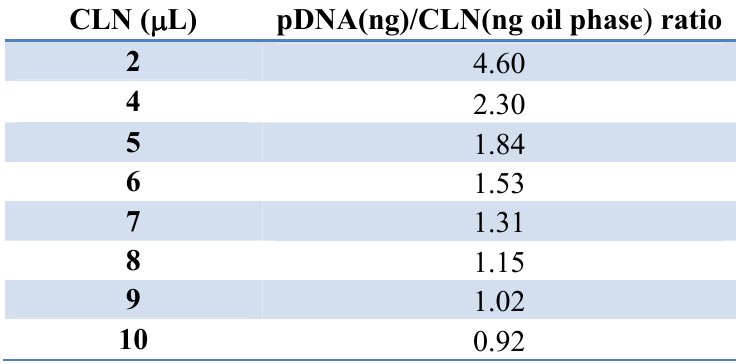
Table 2. Study concentration of CLN and its corresponding pDNA/CLN